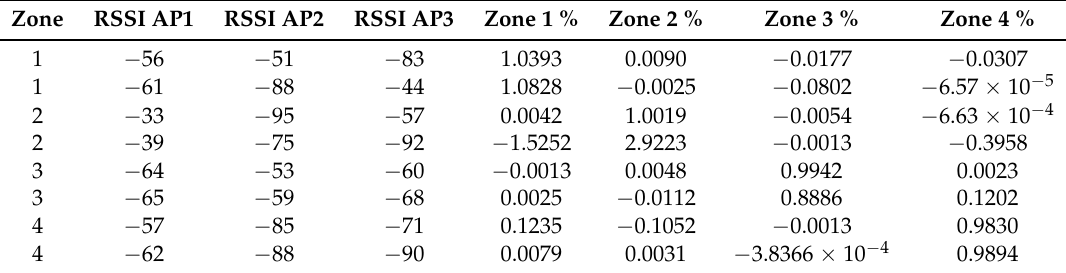
Table 13. Sample of location evaluation, Case Study 3.